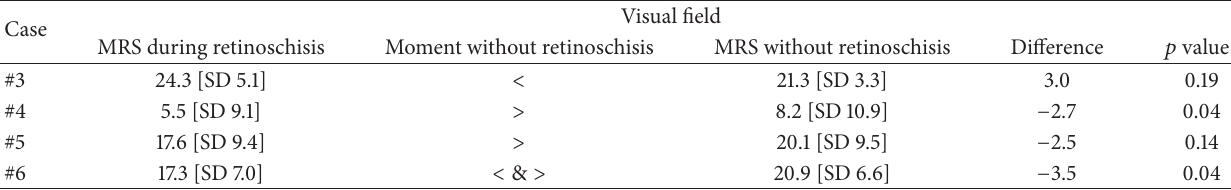
Table 3: Measurement characteristics of visual field of four cases of measurements with and without the focal retinoschisis.